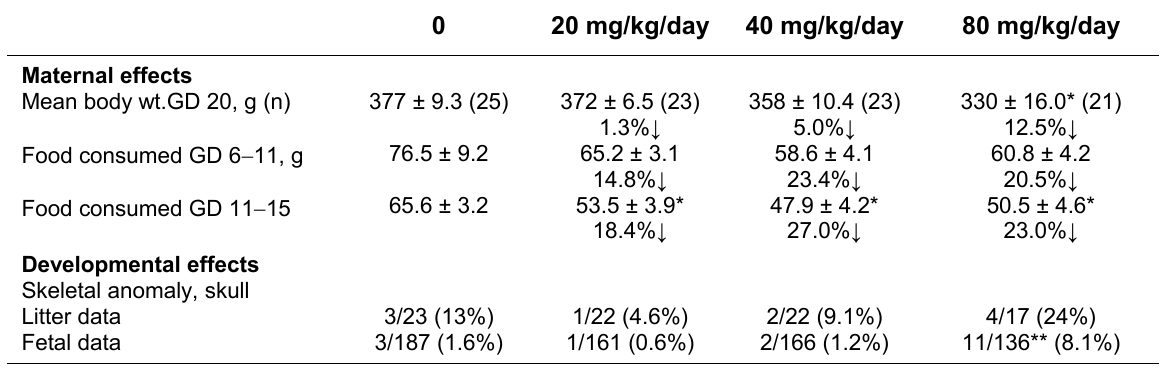
Developmental and Maternal Toxicity of Resmethrin in the Rat